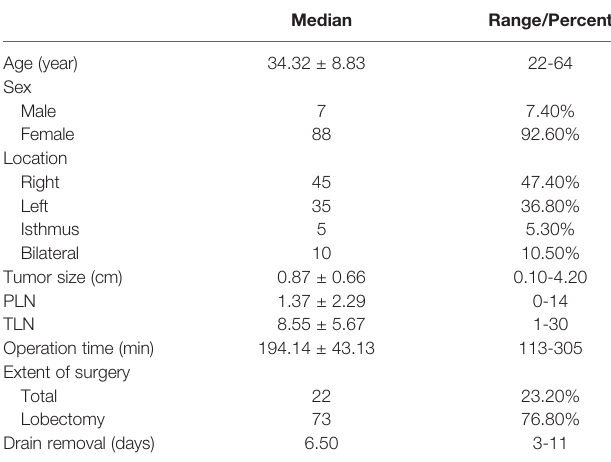
TABLE 1 | Patients characteristics (n =